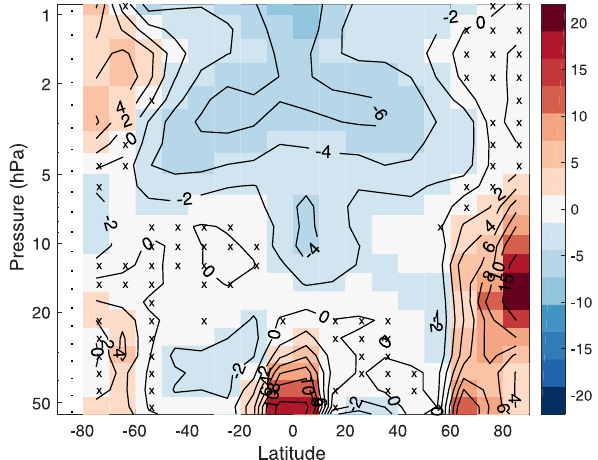
Figure 3. The median relative difference (WACCM– GOMOS)/median(GOMOS) of the ozone mixing ratio (in %) in the mesosphere over 2002–2011. Latitudes are from − 90 to + 90 ◦ with 10 ◦ resolution. A crossed cell marks a point where the difference does not deviate from zero in a statistically significant way. A cell with a dot marks a point where there are no collocated